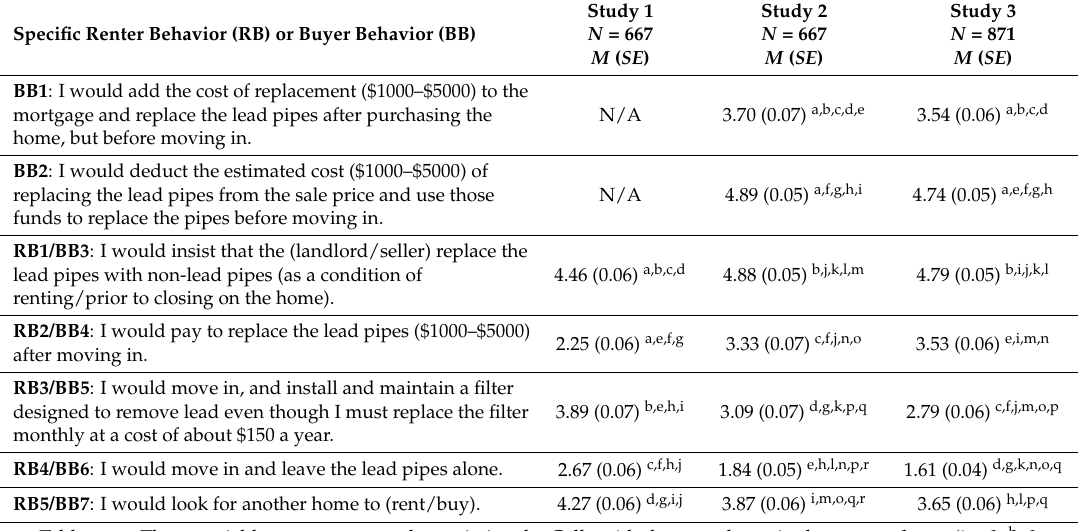
Table note: These variables were measured on a 1–6 scale. Cells with the same letter in the same column (i.e, a , b , c , d , e , f , g , h , i , j , k , l , m , n , o , p , q , r ) in each panel are statistically different at p < 0.05 (One-way repeated measures ANOVA results with Bonferroni corrections). M: mean; SE: standard